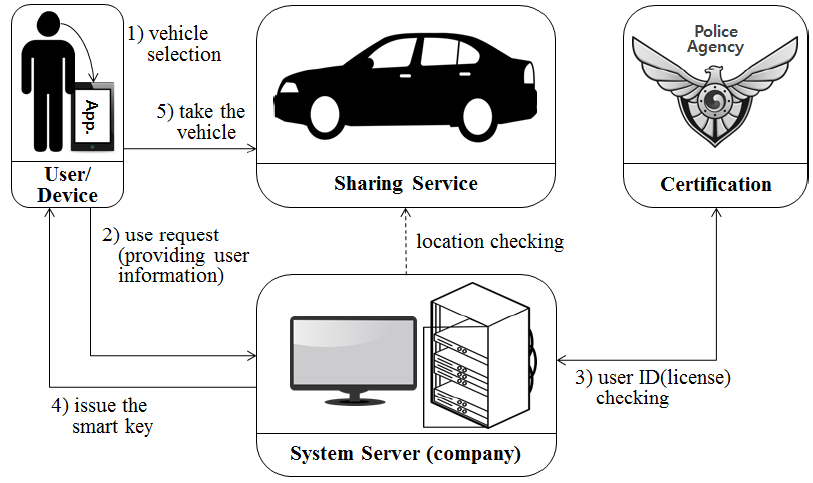
Figure 5. Existing shared vehicle system structure in the IoT.